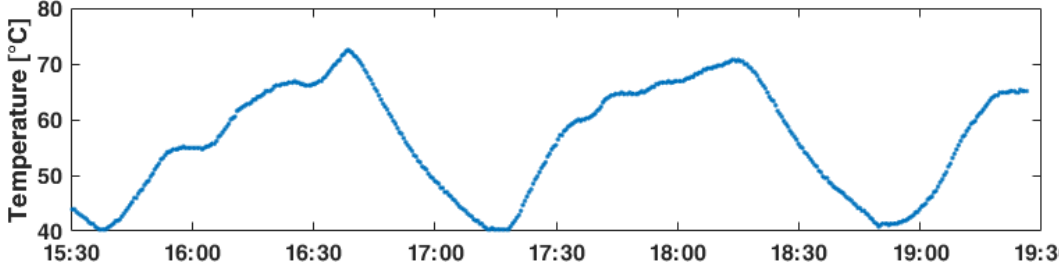
Figure 5. Temperature evolution during active heating of thruster B on 22 May